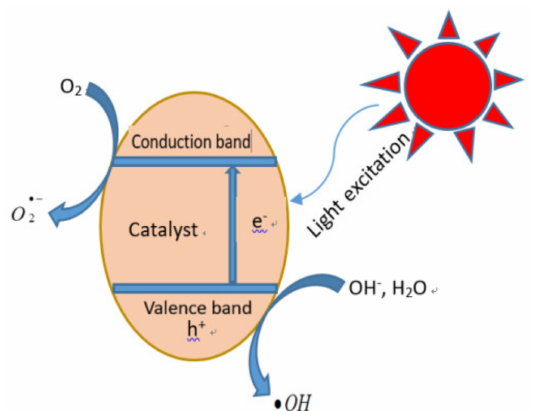
Figure 4. Generation of free radicals during photocatalytic